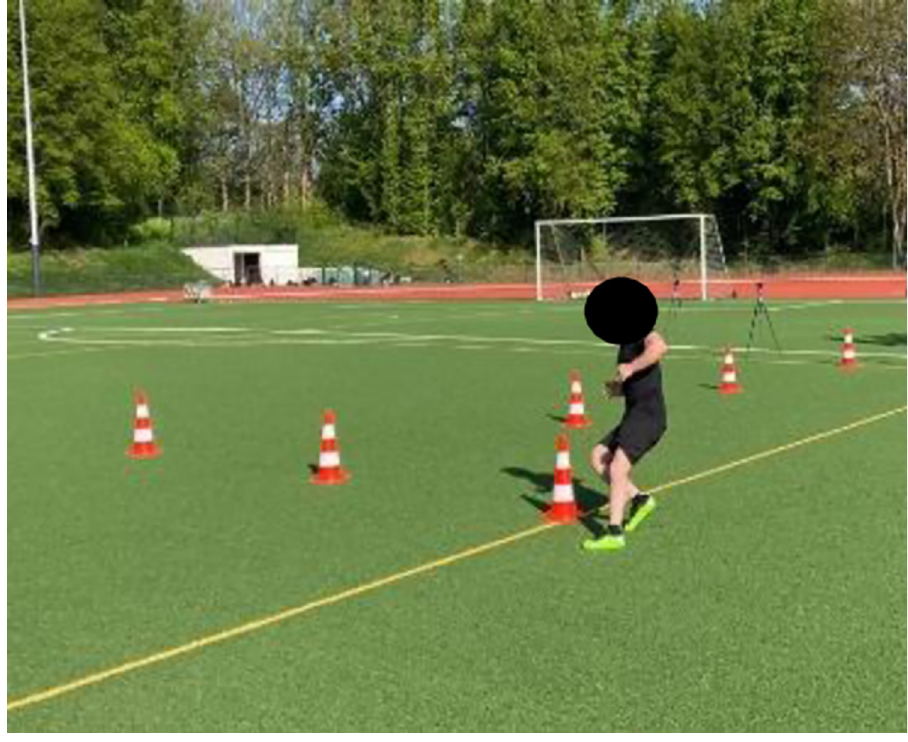
Fig 3. Illinois agility test.